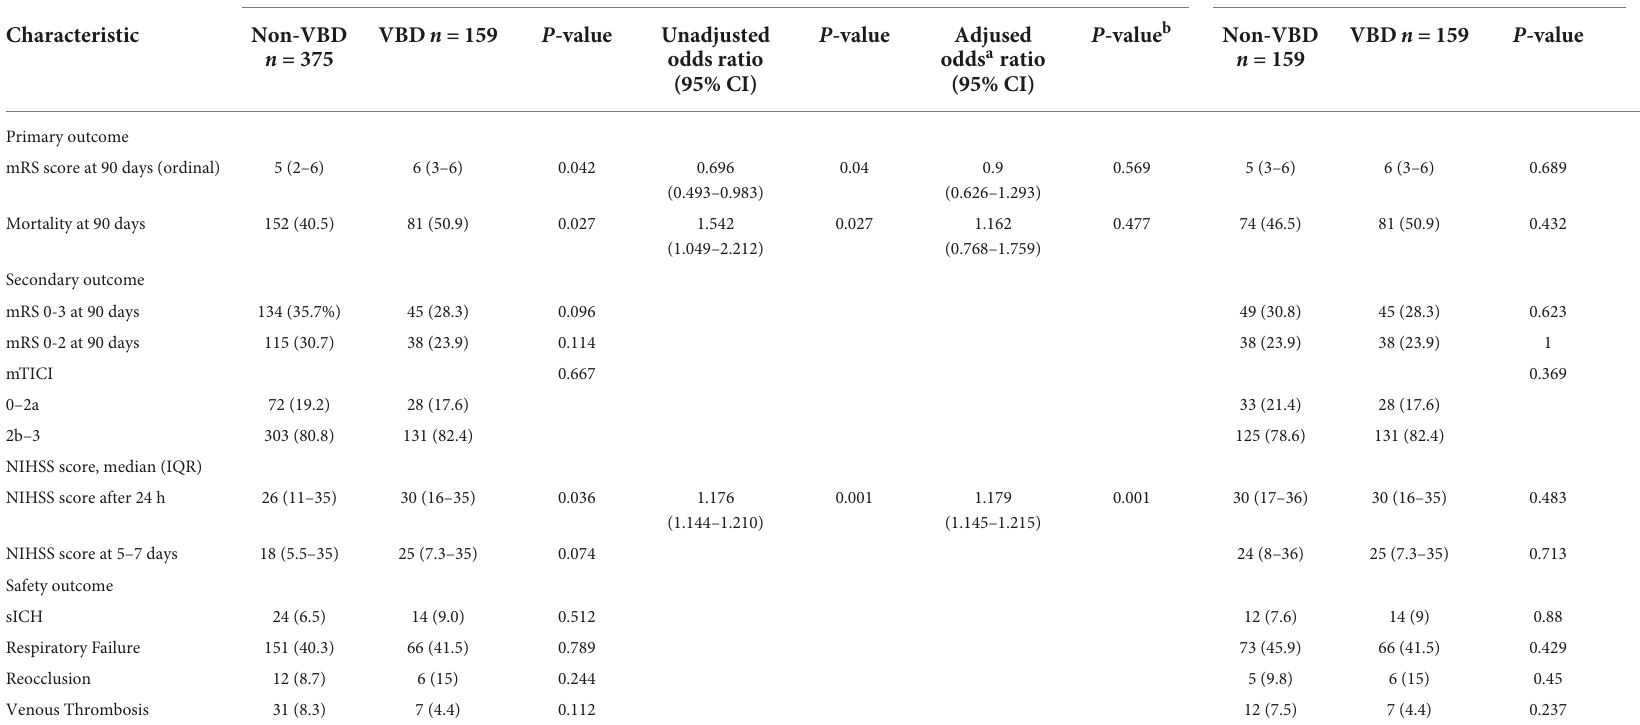
TABLE 2 Primary and secondary efficacy outcomes and safety